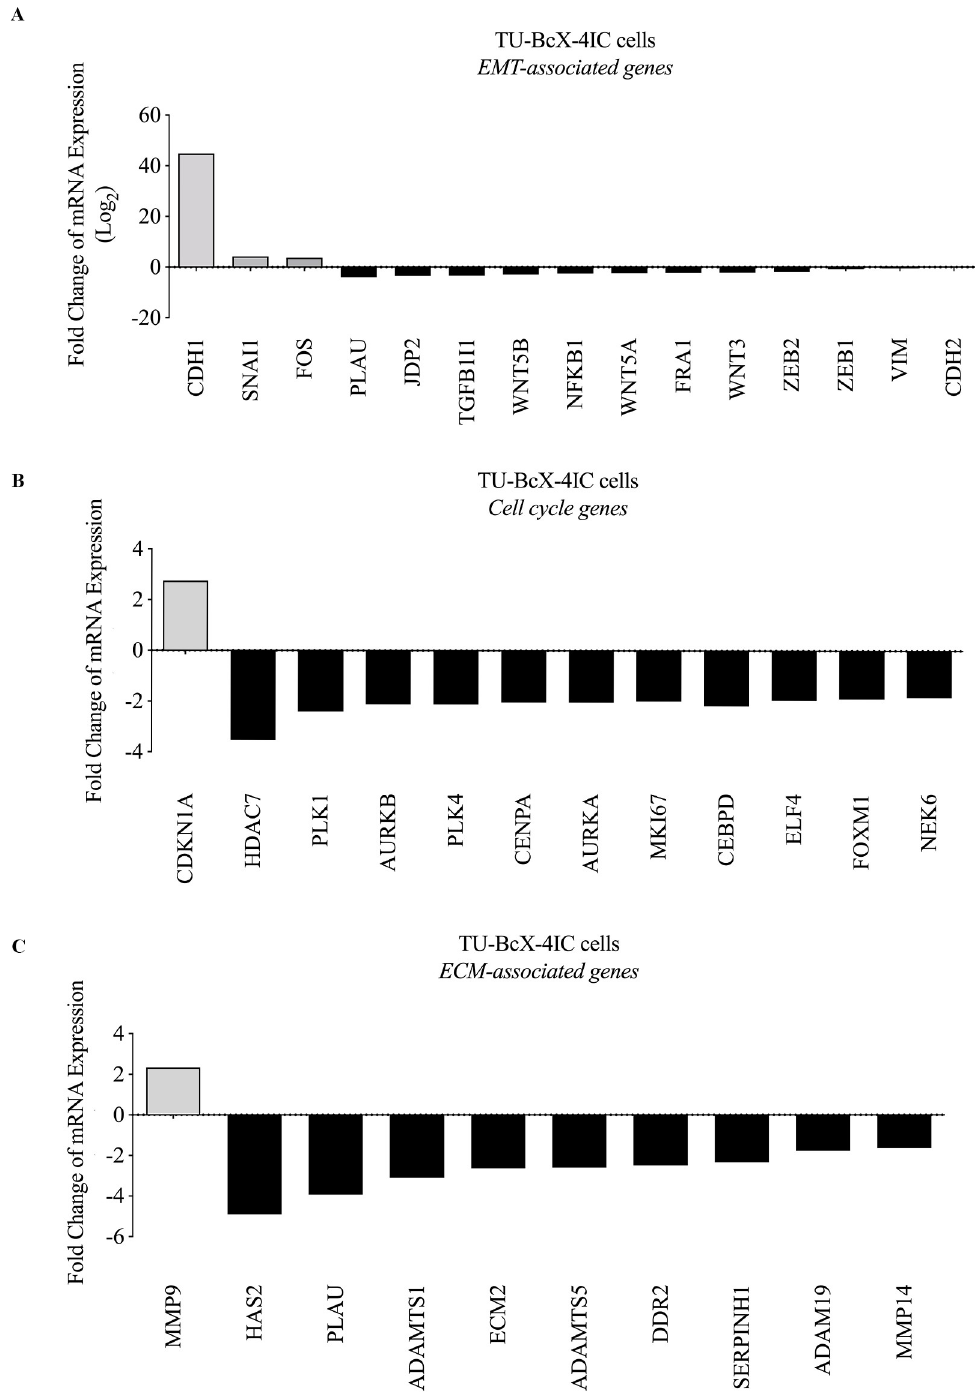
Fig 4. RNA sequencing analysis of romidepsin-treated TU-BcX-4IC cells compared to DMSO control. Romidepsin altered expressions of (A) EMT-related genes. Other cell signaling pathways that were affected include (B) cell cycle genes and (C) extracellular matrix-associated genes in TU-BcX-4IC cells. Data is shown as Log2 (fold change). mRNA expression of EMT genes ( CDH1 , VIM , CDH2 , ZEB1 , ZEB2 ) were analyzed using qRT-PCR.